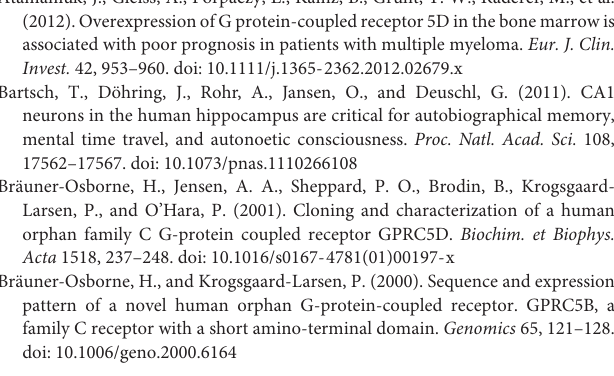
Supplementary Figure 1 | Positive and negative controls for RNAscope analysis of mRNA distribution patterns. In column (A) three mouse specific housekeeping gene Polr2a , UBC , and PPIB were used as positive control probes for technical quality and mRNA preservation check. Ubiquitous signals from Polr2a (red), UBC (green), and PPIB (magenta) were observed in both 10 × stitched images and images at higher magnification (insets). In column (B) in situ hybridization achieved with a probe against the soil bacteria gene DapB was used as a negative control for non-specific hybridization in the corresponding three channels. Scale bar: 500 µ m. Supplementary Figure 2 | Gprc5b mRNA distribution patterns retrieved from Allen brain atlas data portal detected by in situ hybridization. (A) Sagittal brain section of a C57BL/6J mouse showing Gprc5b mRNA distribution. Scale bar: 839 µ m. (B) Coronal mouse brain sections with comparable anatomical positions to images presented in Figure 4 . Scale bar: 1678 µ m. Supplementary Figure 3 | Original western blots of mouse brain biochemical fractionation experiments. Three replicates are